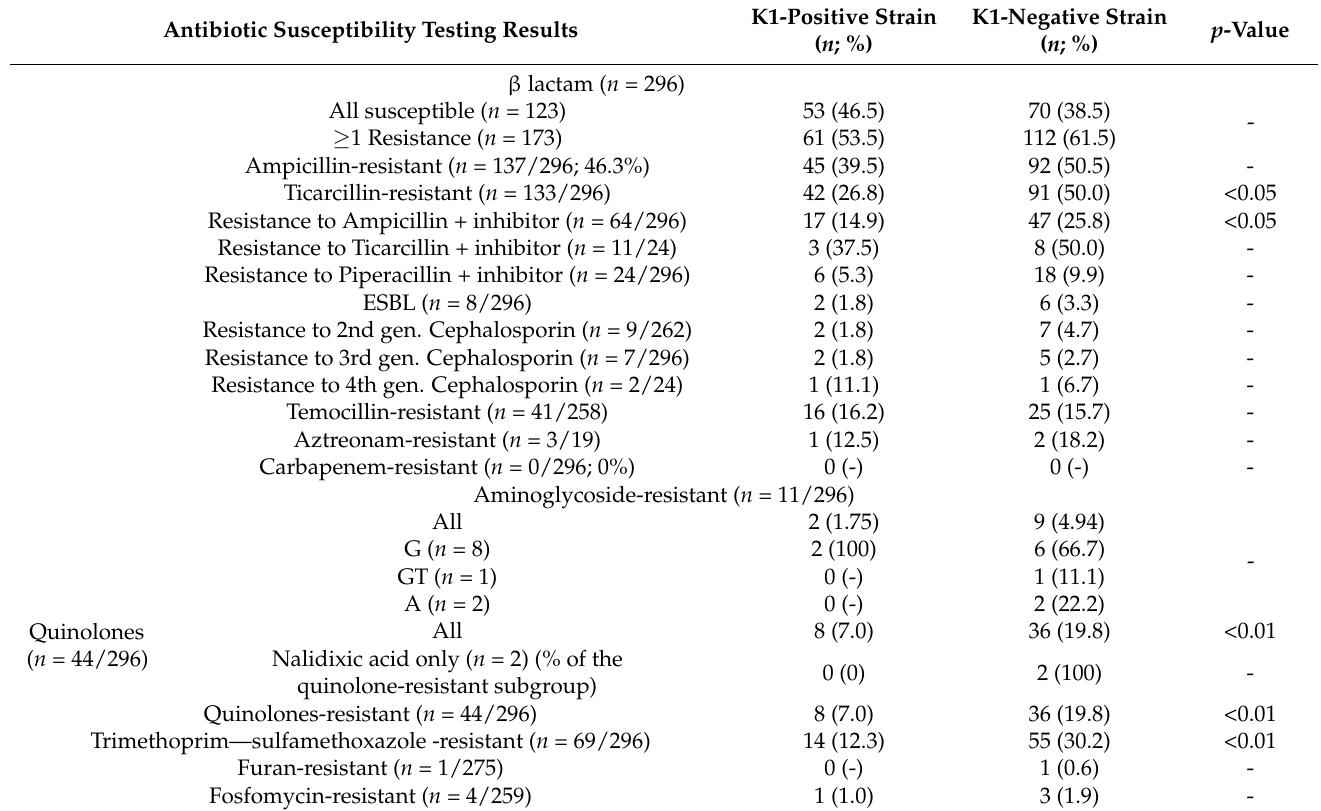
Table 2. Comparison of the AST phenotypes per antibiotic